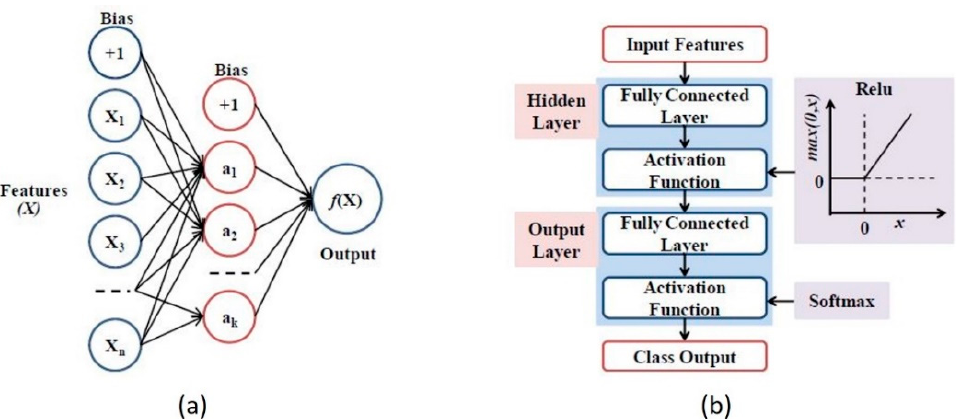
Figure 19. ( a ) Schematic of neural network (NN) based nonlinear signal processing for a hidden layer and ( b ) simple structure of two-layer neural network (reprinted from [48] with permission from authors).